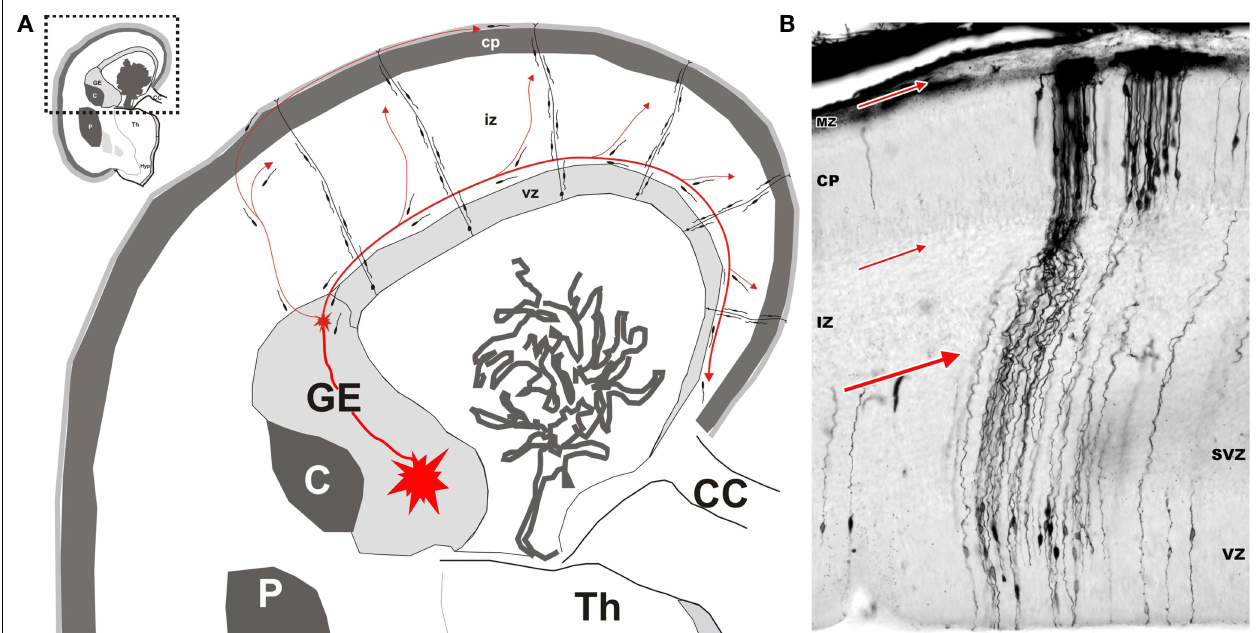
FIGURE 1 | Origin and migratory routes differ between the two major classes of cortical neurons. (A) Shematic drawing of migratory routes for cortical neurons in the dorsal telencephalon (pallium). Principal (pyramidal) neurons (excitatory glutamatergic neurons) originate locally in the proliferative ventricular (VZ) and subventricular (SVZ) zones of the dorsal telencephalon. Early-generated neurons display a bipolar morphology and migrate orthogonal to the surface of the brain along radially oriented glial fi bres (radial migration). According to data obtained in rodents, hippocampal and cortical GABAergic neurons originate in the ventral proliferative zones, i.e. ganglionic eminence (GE) and migrate tangentially to their target cortical regions (red arrowed lines). The largest stream follows the lower intermediate zone (IZ)/upper subventricular zone (SVZ). In the marginal zone (MZ), the stream of migrating